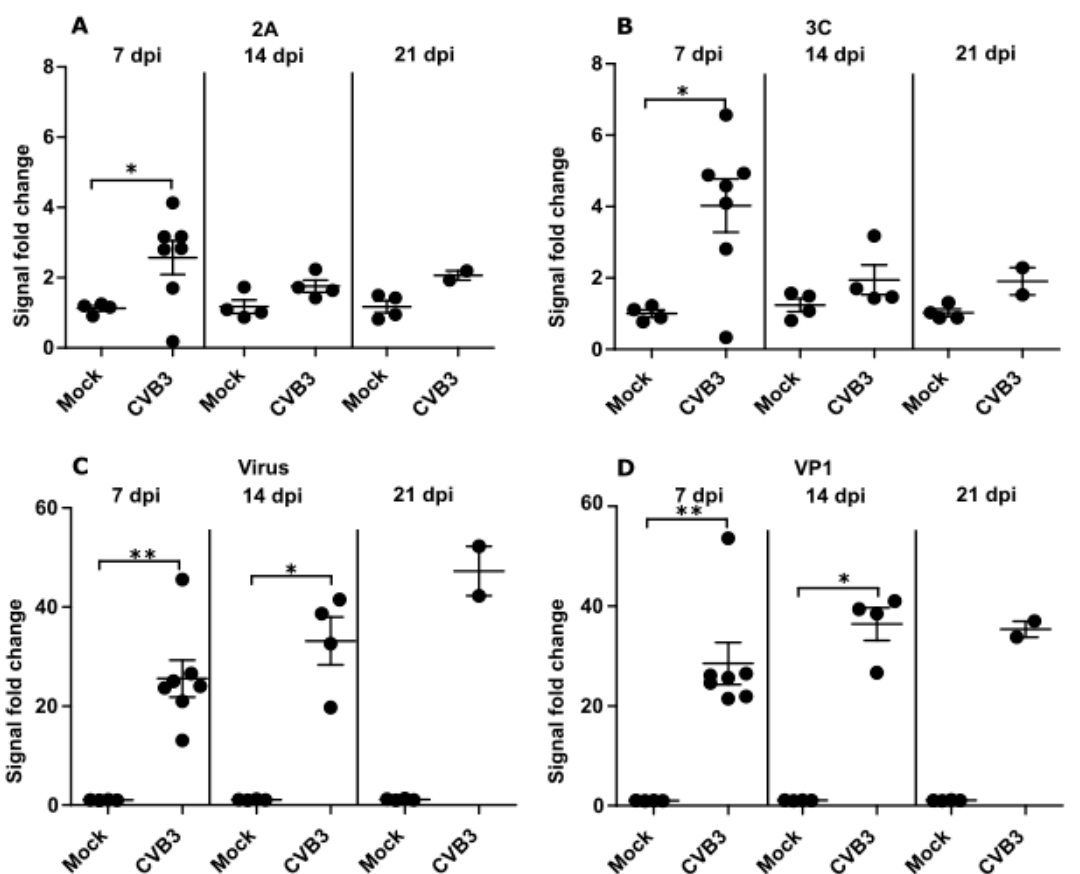
Figure 3. CVB-infection induces a short-lived antibody response towards CVB3 proteases in mice. Antibody responses towards the protease antigens ( A ) 2A and ( B ) 3C (at 1:1000 dilutions) and to the ( C ) structural proteins in whole virus and ( D ) the capsid protein VP1 (1: 64,000) in CVB3 infected mice measured using ELISA. The data is shown as the fold change compared to antibody responses from pre-infection serum samples. Each data point is an average of three parallel samples. Stat: Mann–Whitney test, means and standard errors of means shown as gray bars, * p < 0.05 and ** p < 0.001.